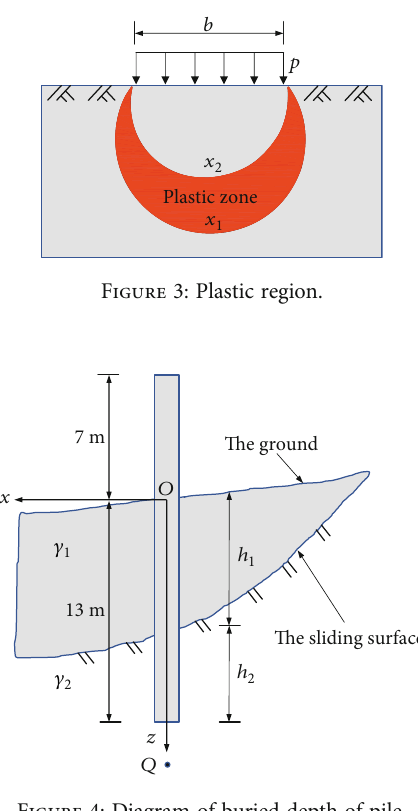
Figure 4: Diagram of buried depth of